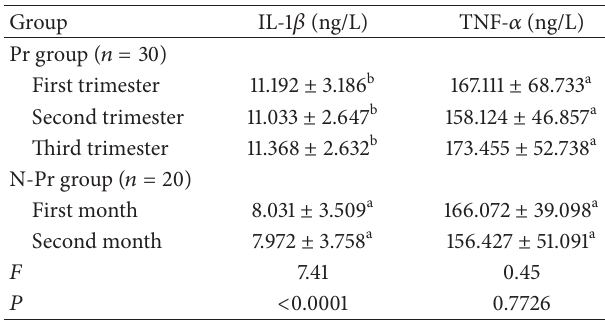
Table 4: IL-1 𝛽 and TNF- 𝛼 level in pregnant group and nonpregnant group ( 𝑥 ± 𝑠 ).